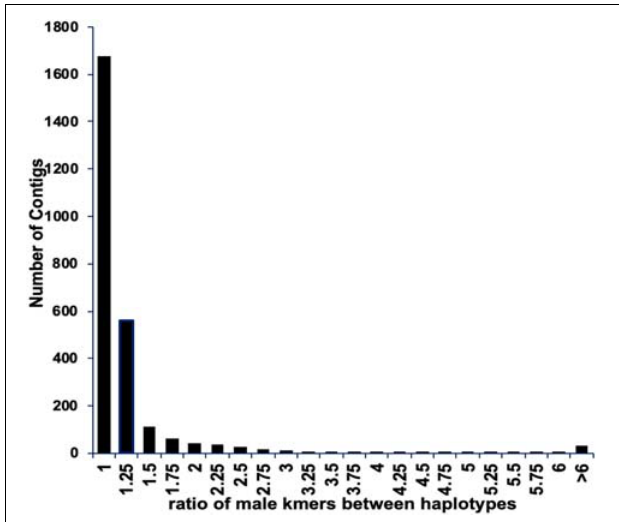
FIGURE 3 | The ratio of male-specific kmers between both haplotypes of the phased Deglet Noor male assembly. Most contigs did not show a difference in the numbers of male-specific kmers matching each contig suggesting a lack of phasing separation or that the kmers are not truly Y chromosome specific. Contigs with greater than 2.5X difference in numbers of male-specific kmers between the two phases were considered for future analysis.